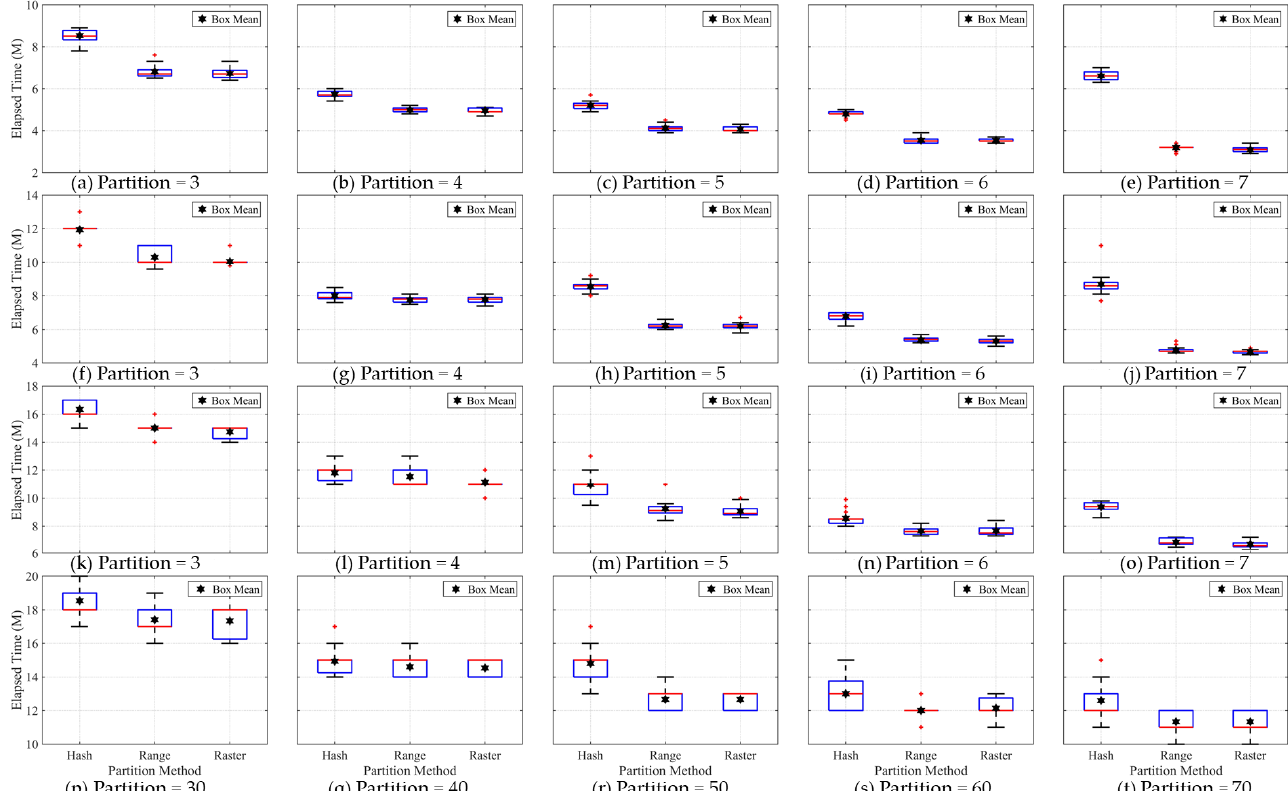
Figure 8. The elapsed time for image segmentation testing.